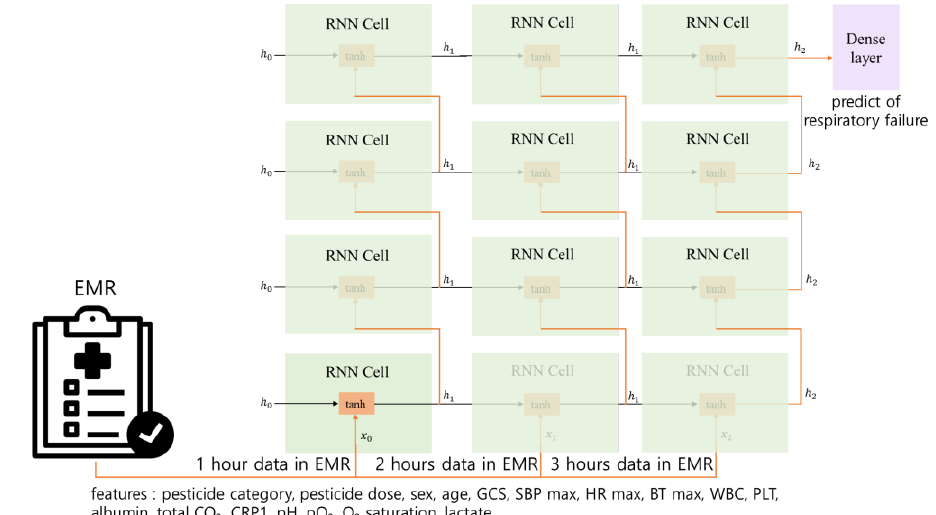
Figure 13. Structure of the RNN model in this paper. The number of units in the RNN layer is 128.